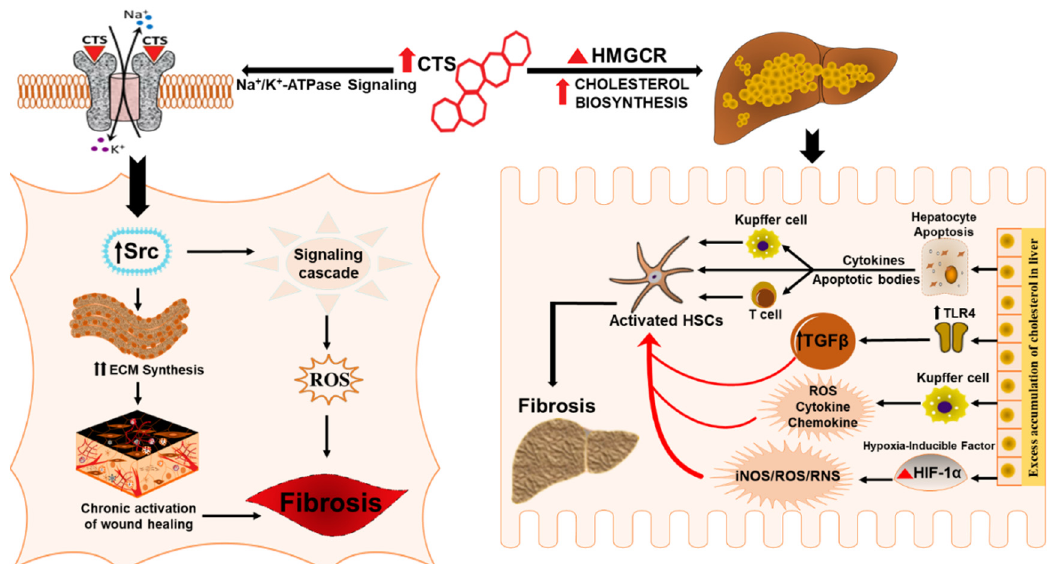
Figure 3. Schematic representation for the potential role of CTS in inducing hepatic fibrosis. CTS could potentiate liver fibrosis in chronic liver disease by inciting cholesterol biosynthesis, evoking wound healing effect and collagen synthesis through the CTS mediated activation of Na/K-ATPase signaling.